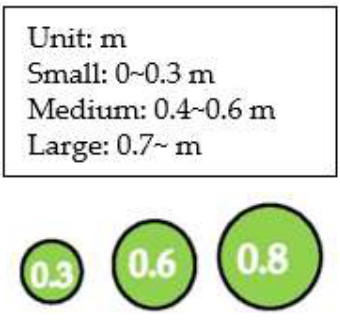
Figure 6. The levels of tide height.